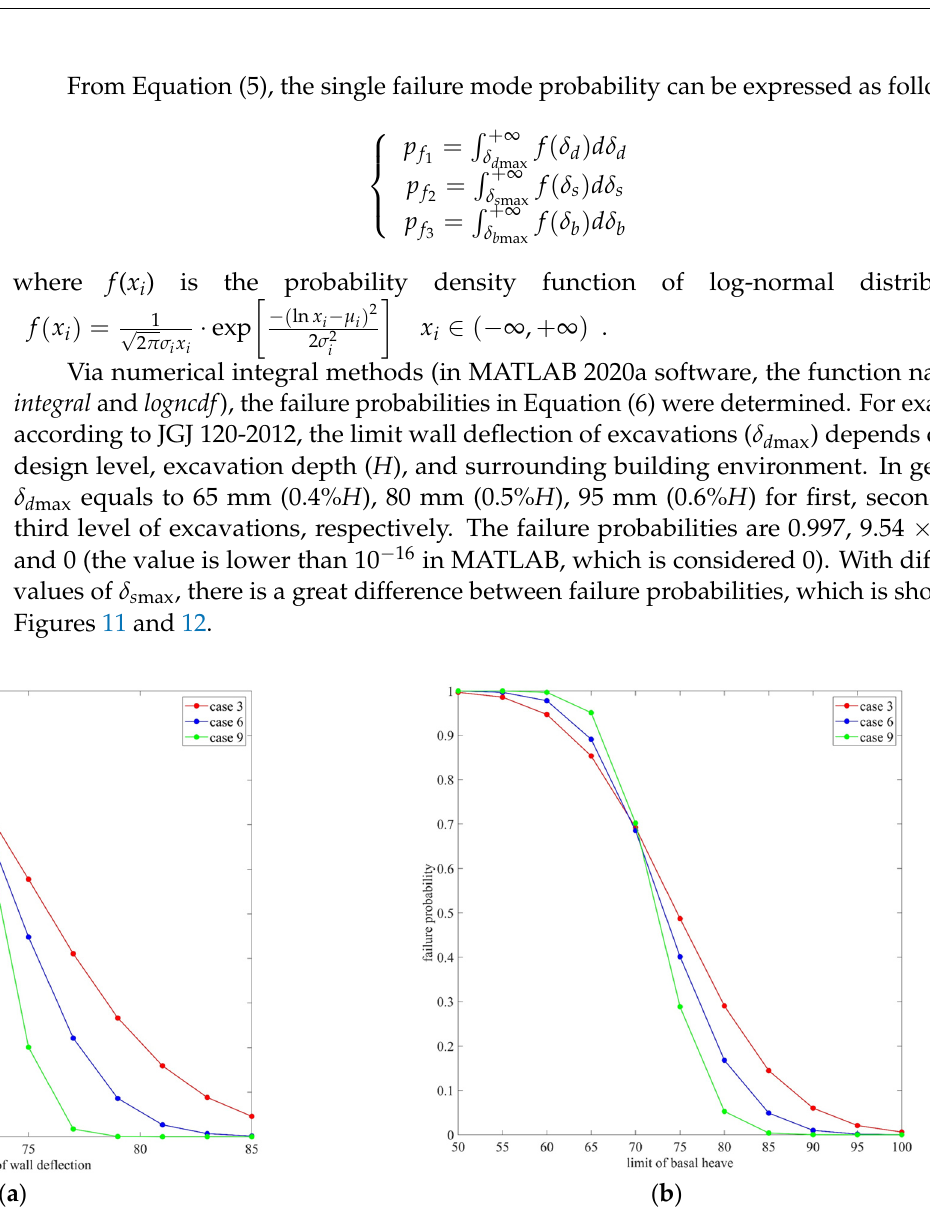
Figure 11. Spatial variability effects on failure probability: ( a ) different thresholds of wall deflection; ( b ) different thresholds of basal heave. From Figure 11, δ s max ranges from 65 mm to 85 mm. The curves represent